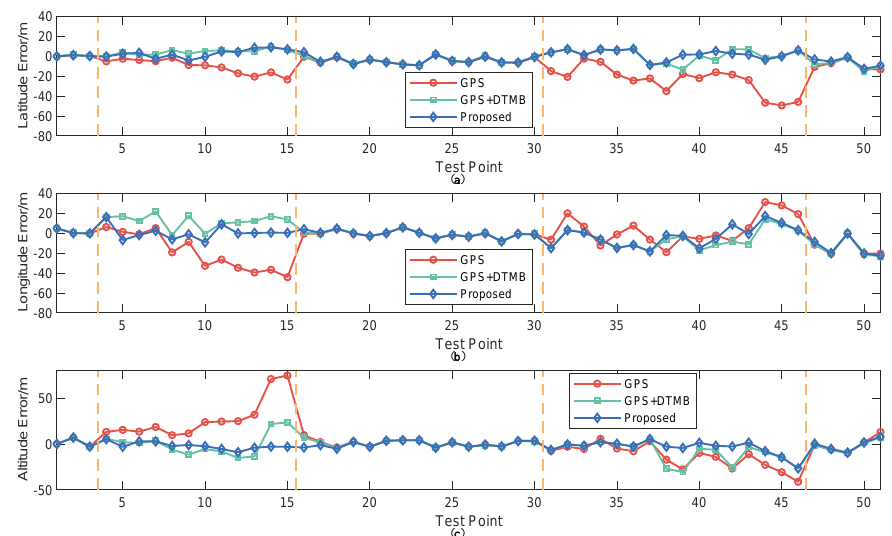
Figure 11. Positioning error of each point in latitude/longitude/altitude direction. ( a ) error in latitude direction; ( b ) error in longitude direction; and ( c ) error in altitude